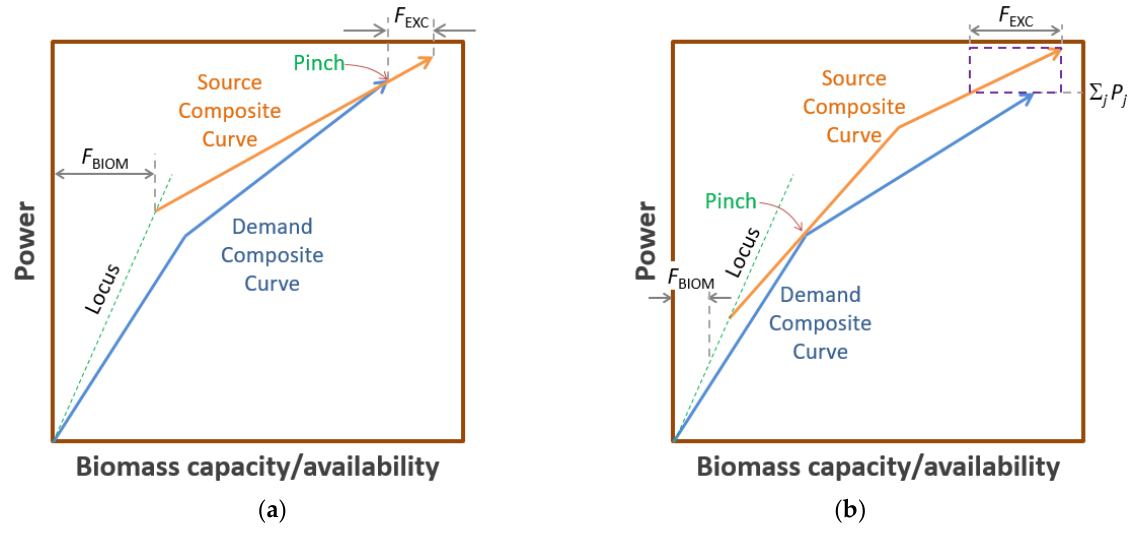
Figure 3. Feasible BEPD with ( a ) pinch occurs at the end of the demand composite curve; ( b ) pinch occurs at the middle section of the demand composite curve.